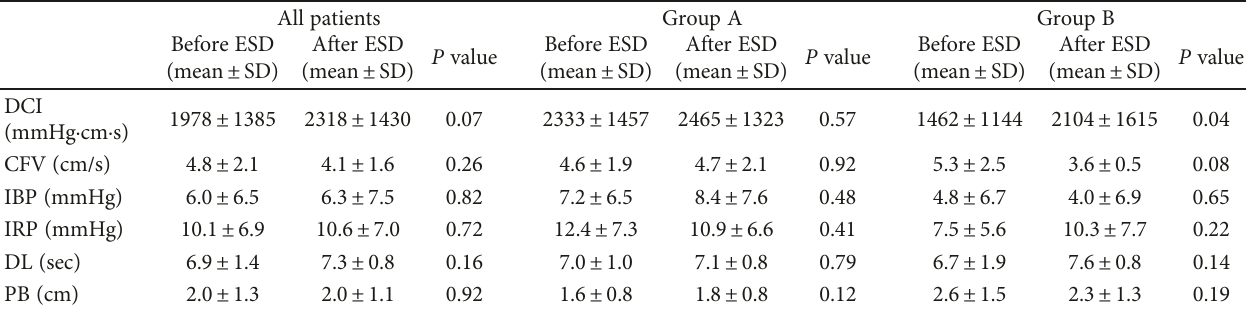
Table 3: High-resolution manometry data.